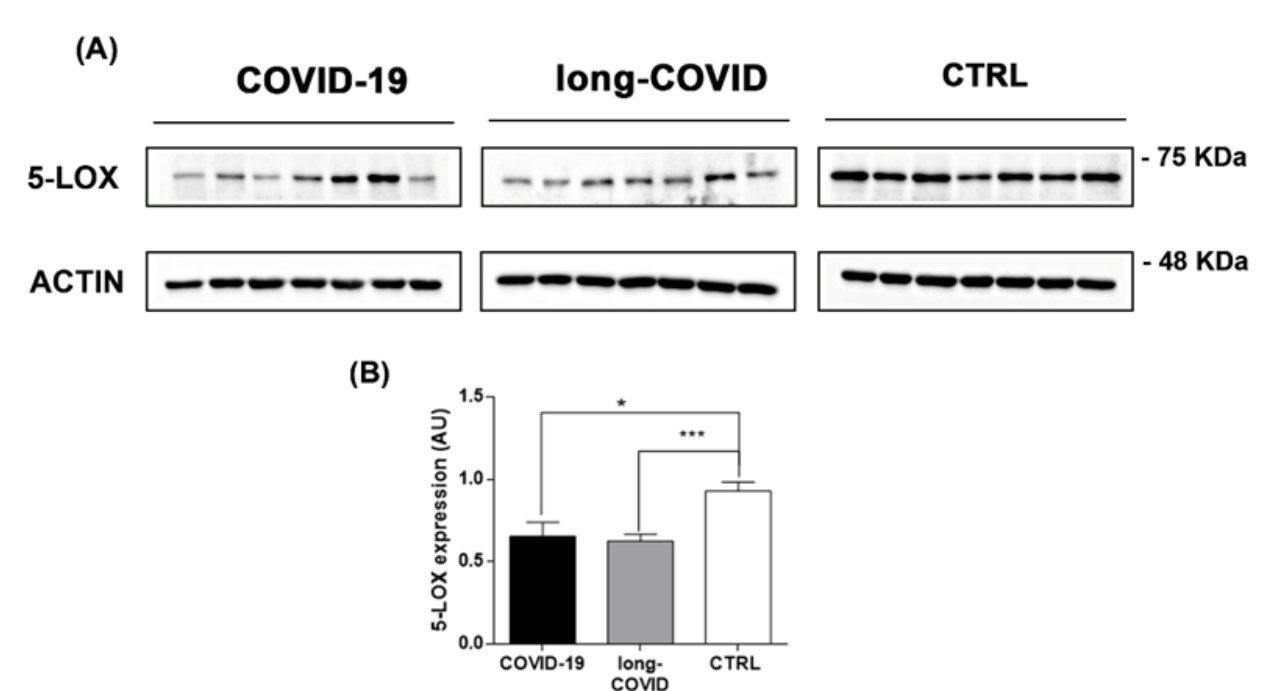
Figure 3. 5-LOX is modulated in COVID-19 and long-COVID patients. ( A ) 5-LOX protein levels were analyzed in PBMCs isolated from COVID-19 patients (n = 7), long-COVID (n = 7), and healthy donors (n = 7) using Western blot, and ( B ) bands intensities were quantified using Image J and reported as arbitrary units (AU). Data reported in this figure are the mean ± SE of two independent experiments (* p < 0.1, *** p < 0.001).